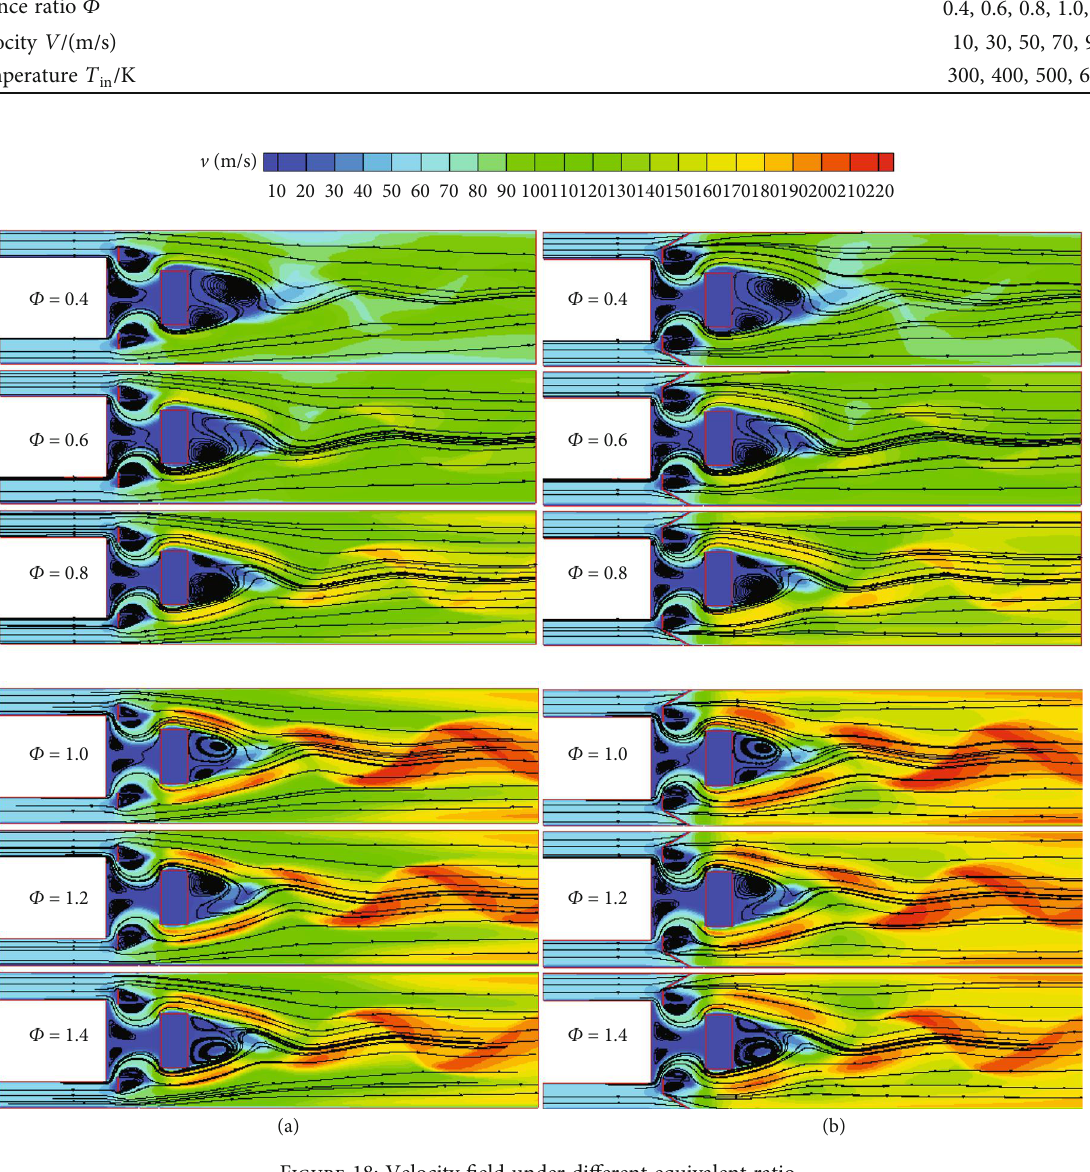
Figure 18: Velocity fi eld under di ff erent equivalent ratio.